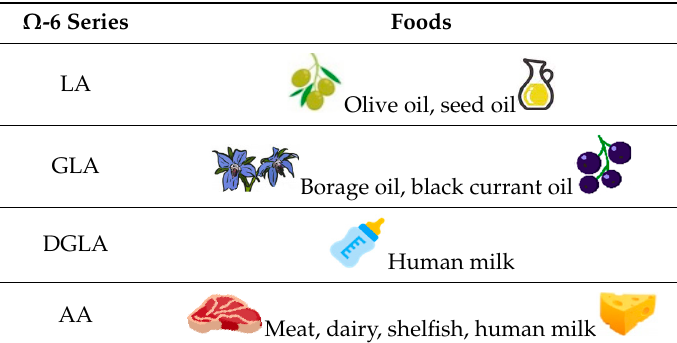
Table 2. Main dietary sources of ω -6 fatty acids.